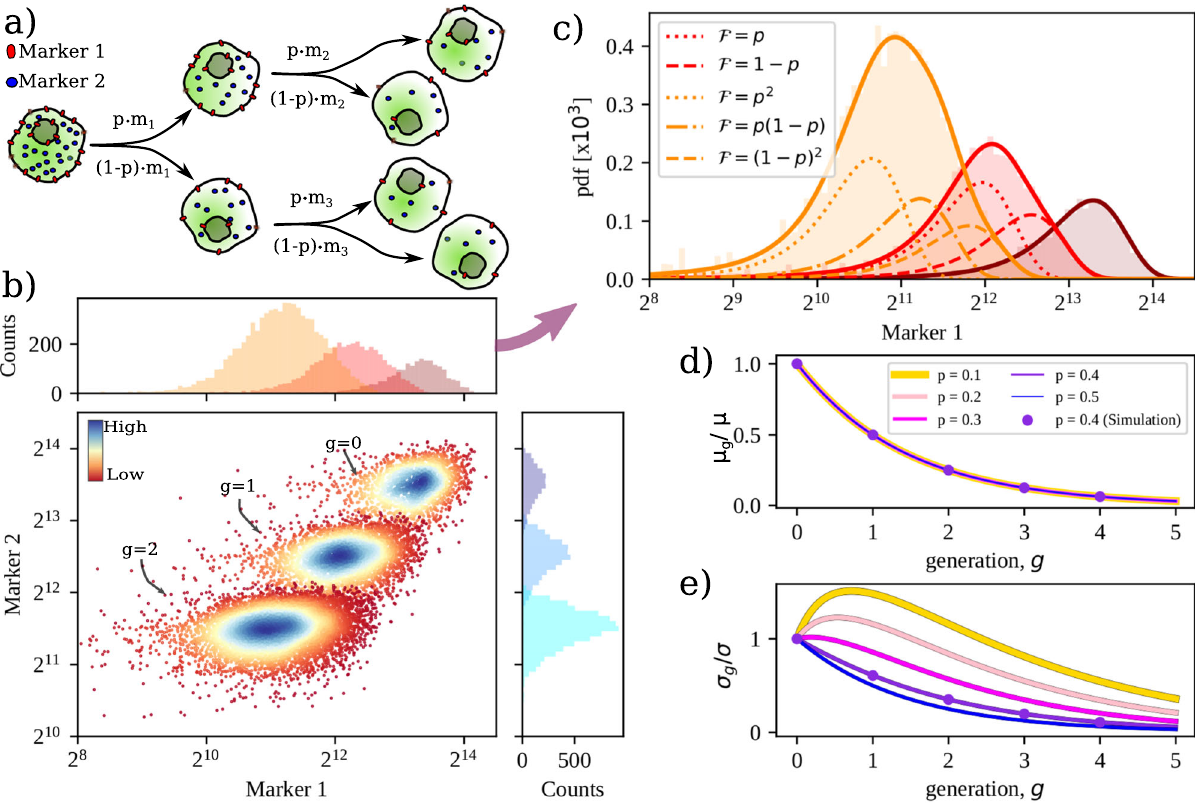
Fig. 3 Theoretical predictions for the Bernoulli partition process. a Sketch of the division process of a cell having two kinds of sub-components marked with blue and red dyes. When a cell i with m i sub-components divides, m 2 i sub-components go to one daughter cell with probability p , and m 2 i + 1 = m i − m 2 i sub-components go to the other daughter cell, with probability (1 − p ). When the two daughters divide in turn, the sub-components inherited from the mother are further divided into niece cells. b Number of markers 1 and 2 per cell. Each cloud of points corresponds to a different generation. Points are colored from red to blue as the local density of points in the plot increases. Histograms represent the marginal distributions for the two markers. c Marginal distribution of marker 1 copy-numbers for generation 0 (dark red), 1 (red), and 2 (orange). For each generation, the dotted curves are associated with the different daughter cells subpopulations that originated from the previous generation, depending on the partition probability, p . Each sub-population can be associated with a product, F , of fraction probabilities which depends on the division path. d Mean number of marked compounds per cell, μ g divided by the mean at generation zero, μ , as a function of the generation, g for different possible values of the partition fraction, p . Solutions of Eq. (17) are represented with lines while dots stand for simulated values. e Square root variance of the number of marked compounds per cell, σ g , divided by the square root variance at generation zero, μ , as a function of the generation, g for different possible values of the partition fraction, p